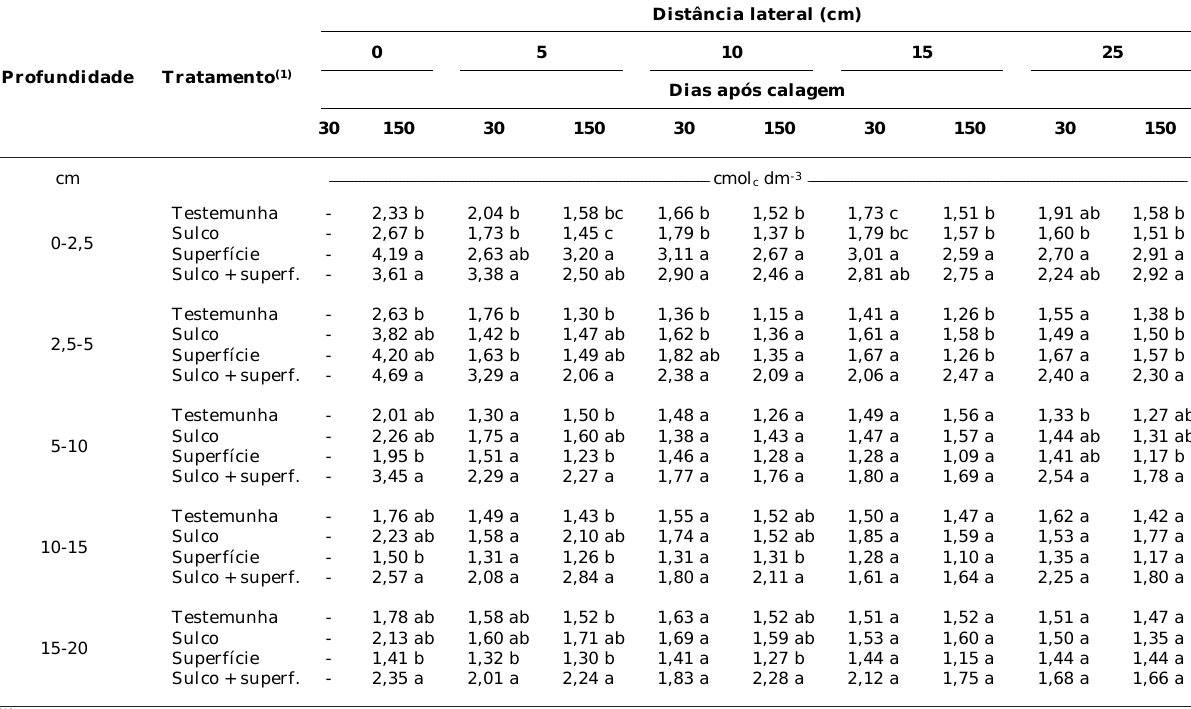
Quadro 3. Valores médios de cálcio trocável nos diferentes tratamentos amostrados aos 30 e 150 dias da calagem, nas distâncias laterais a partir da linha de semeadura (0, 5, 10, 15 e 25 cm) e nas